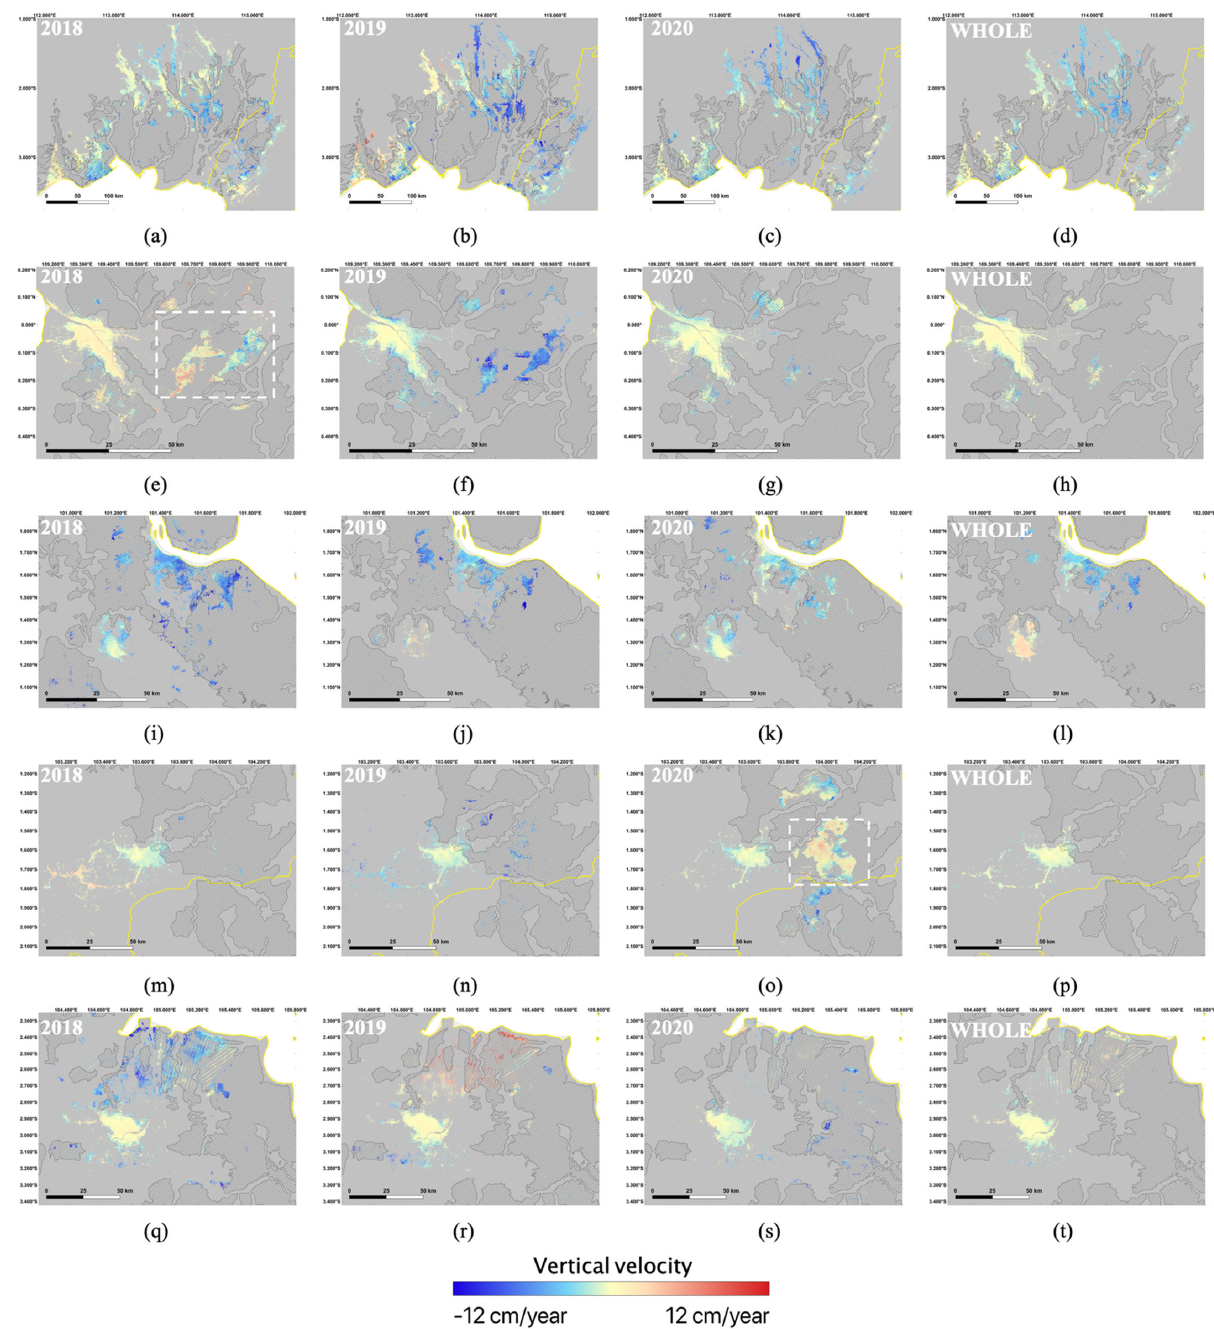
Figure 11. Vertical deformation velocity images for seven Sentinel-1A frames derived by SUBSET and WHOLE. ( a ) SUBSET 2018 result for Frames 1,2, and 3. ( b ) SUBSET 2019 result for Frames 1,2, and 3. ( c ) SUBSET 2020 result for Frames 1,2, and 3. ( d ) WHOLE result for Frames 1,2, and 3. ( e ) SUBSET 2018 result for Frame 4. ( f ) SUBSET 2019 result for Frame 4. ( g ) SUBSET 2020 result for Frame 4. ( h ) WHOLE result for Frame 4. ( i ) SUBSET 2018 result for Frame 5. ( j ) SUBSET 2019 result for Frame 5. ( k ) SUBSET 2020 result for Frame 5. ( l ) WHOLE result for Frame 5. ( m ) SUBSET 2018 result for Frame 6. ( n ) SUBSET 2019 result for Frame 6. ( o ) SUBSET 2020 result for Frame 6. ( p ) WHOLE result for Frame 6. ( q ) SUBSET 2018 result for Frame 7. ( r ) SUBSET 2019 result for Frame 7. ( s ) SUBSET 2020 result for Frame 7. ( t ) WHOLE result for Frame 7.